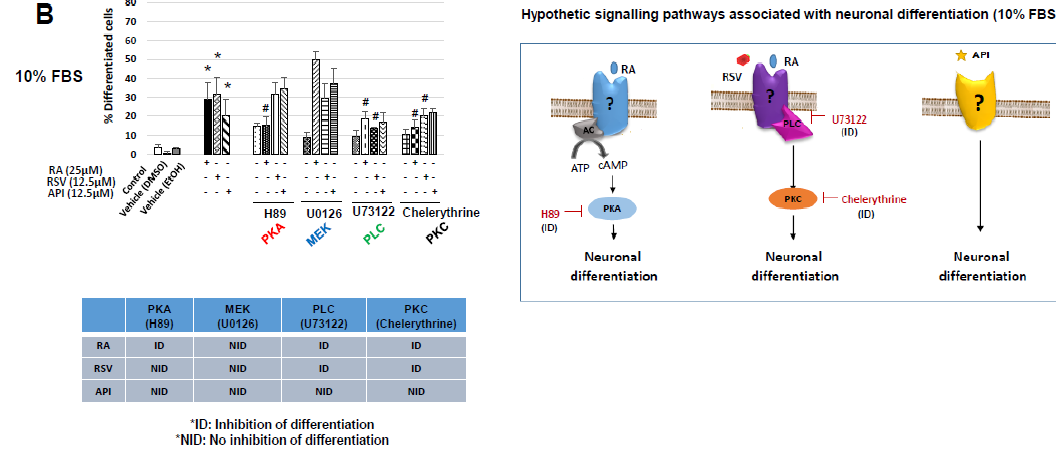
Figure 5. Evaluation of protein kinase A (PKA), phospholipase C (PLC)/protein kinase C (PKC) and the MEK/ERK signaling pathways in resveratrol- and apigenin-induced neuronal differentiation of N2a cells cultured without FBS (0% FBS) and with 10% FBS. Murine neuronal N2a cells previously